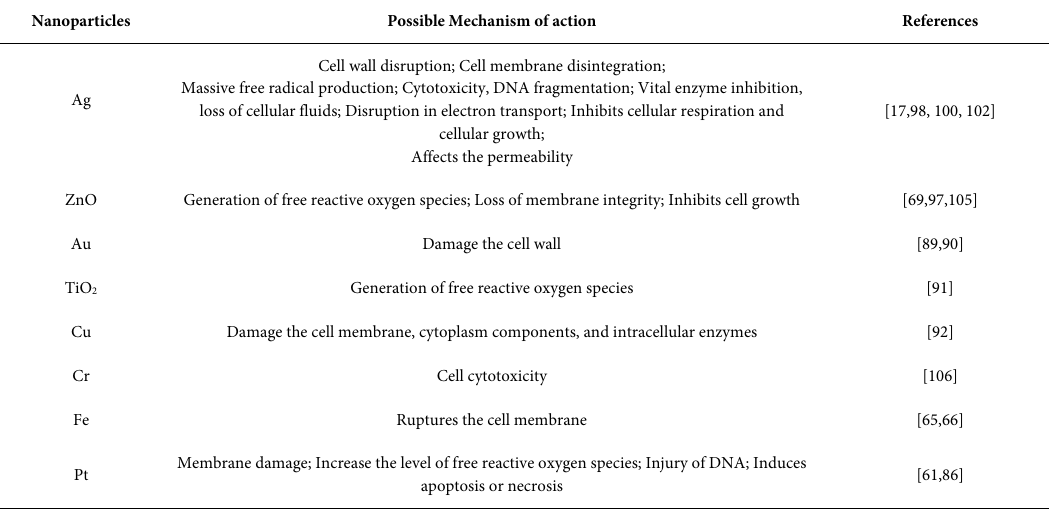
Table 3. Mechanism of antimicrobial action of inorganic Nanoparticles Possible Mechanism of action